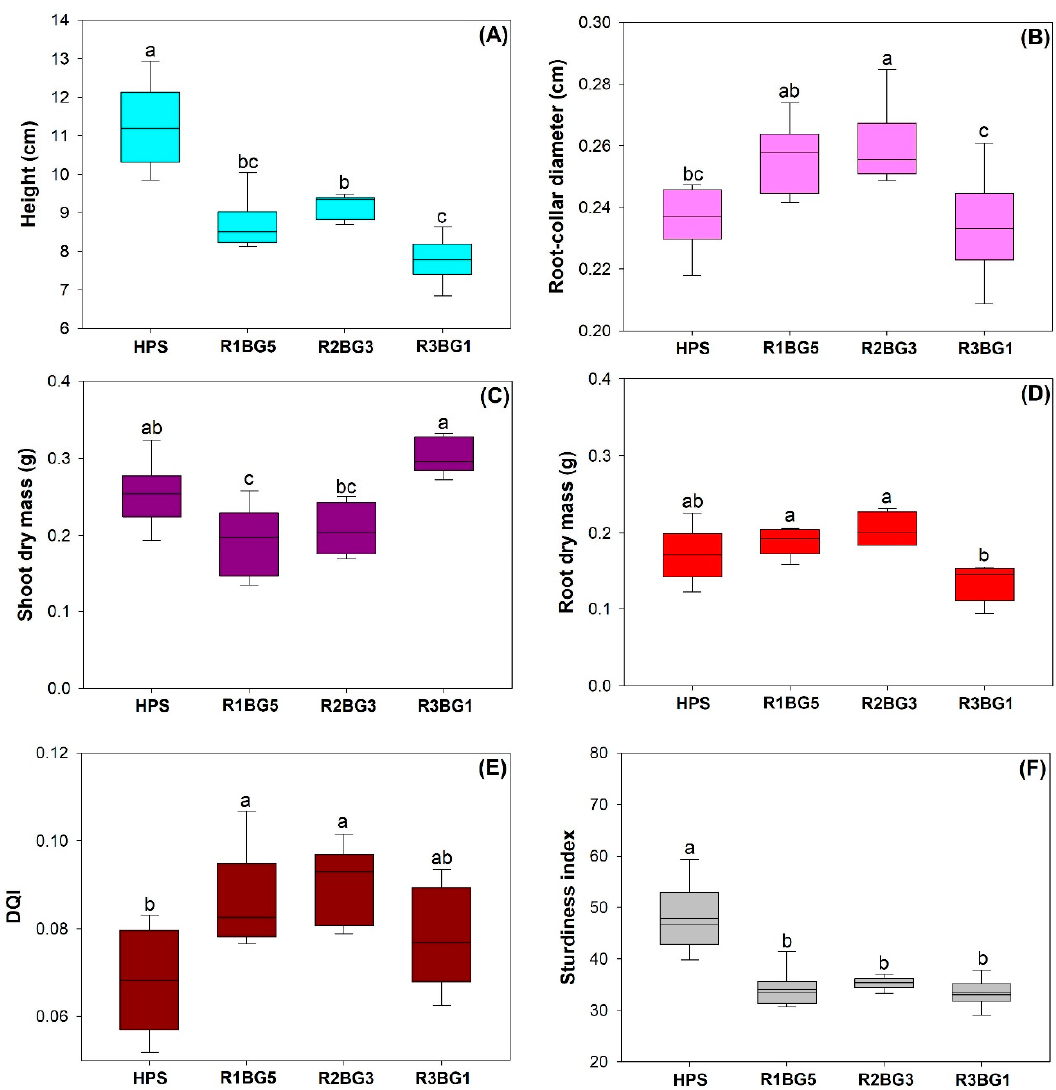
Figure 4. Growth ( A , B ), biomass ( C , D ), and quality assessment ( E , F ) for Korean pine ( Pinus koraiensis ) seedlings under three LED-spectra treatments (R1BG5, R2BG3, and R3BG1) with a high-pressure sodium (HPS) spectrum as the control. Different letters indicate a significant difference according to Tukey’s test at the 0.05 level. DQI—Dickson quality index.